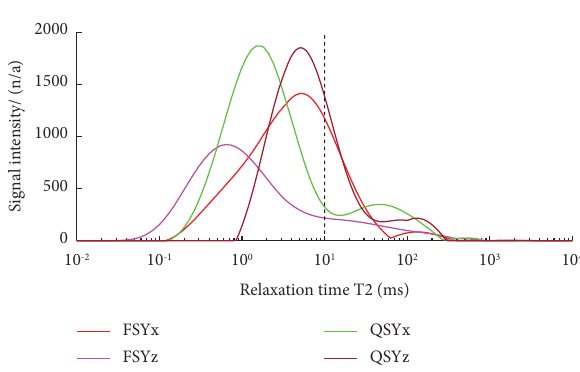
Figure 2: T 2 spectrum of original sandstone samples.